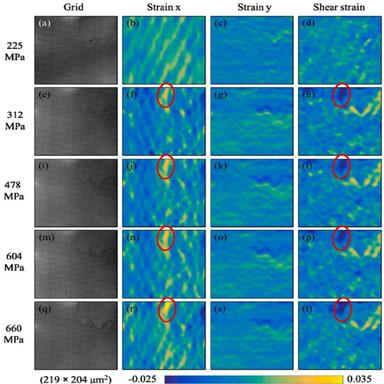
Distributions of x- and y-directions and shear strains of the titanium alloy under tensile loads of (a)–(d) 225 MPa, (e)–(h) 312 MPa, (i)–(l) 478 MPa, (m)–(p) 604 MPa, and (q)–(t) 660 MPa. The copyright permission for this figure has been granted.